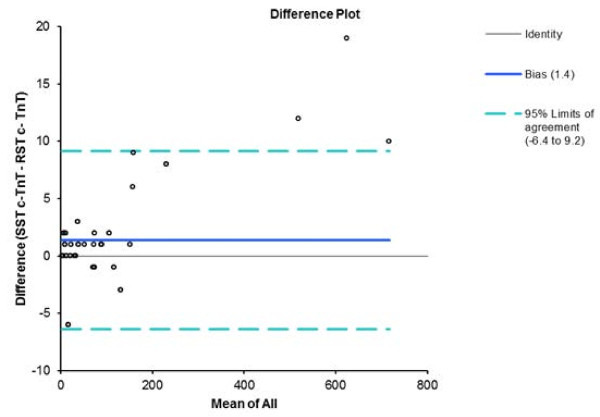
Bland-Altman plot of SST and RST tube hs-cTnT results showing the 95% limits of agreement.